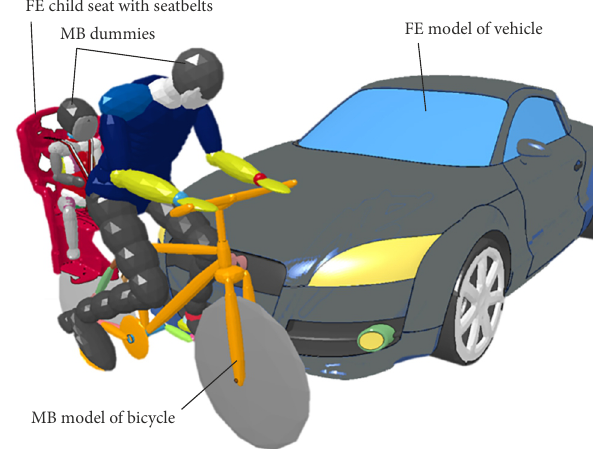
Figure 3. Initial setup for the rear-mounted baby carrier without luggage rack support – the type of numerical models is indicated for coupled